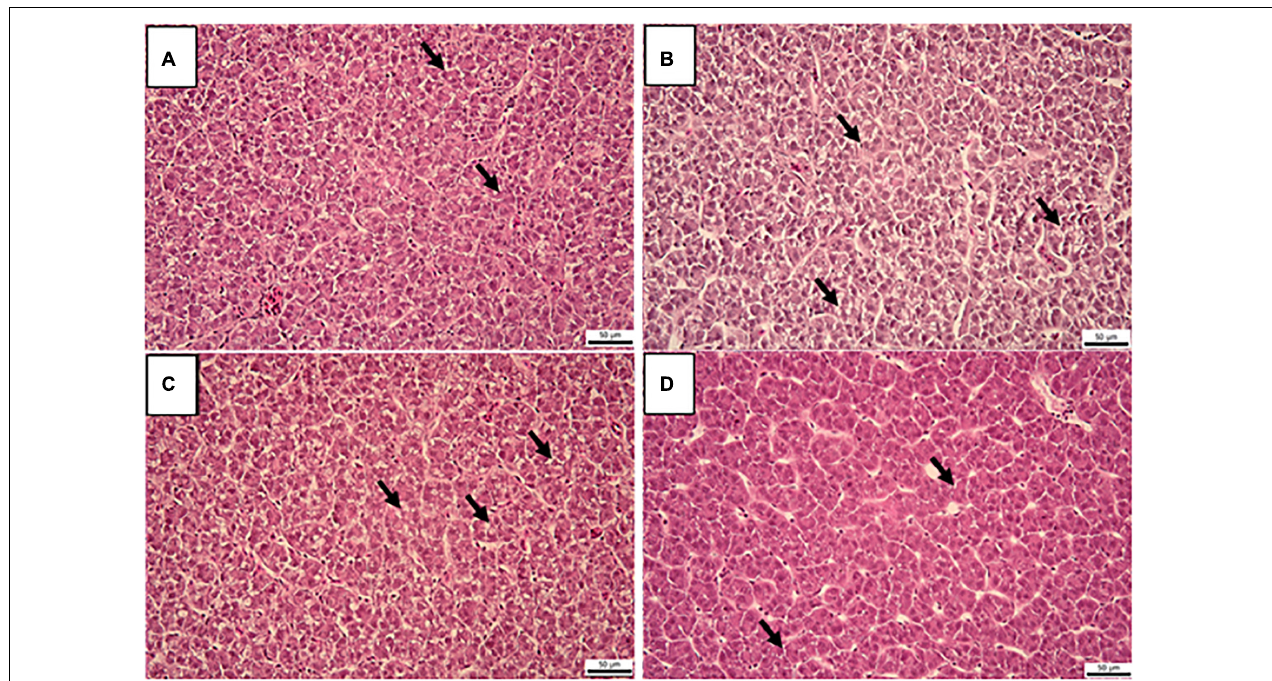
FIGURE 2 | Cross sections of liver in rainbow trout fed fresh fish oil diet (FFO diet, (A) ), oxidized fish oil containing diet (OFO diet, (B) ), OFO diet supplemented with 500 mg kg − 1 VC and 400 mg kg − 1 VE (OFO+C500+E400, (C) ) or 1,000 mg kg − 1 VC and 800 mg kg − 1 VE (OFO+C1000+E800, (D) ) for 10 weeks. Arrows indicate vacuoles in the cytoplasm (H&E, scale bar 50 µ m).